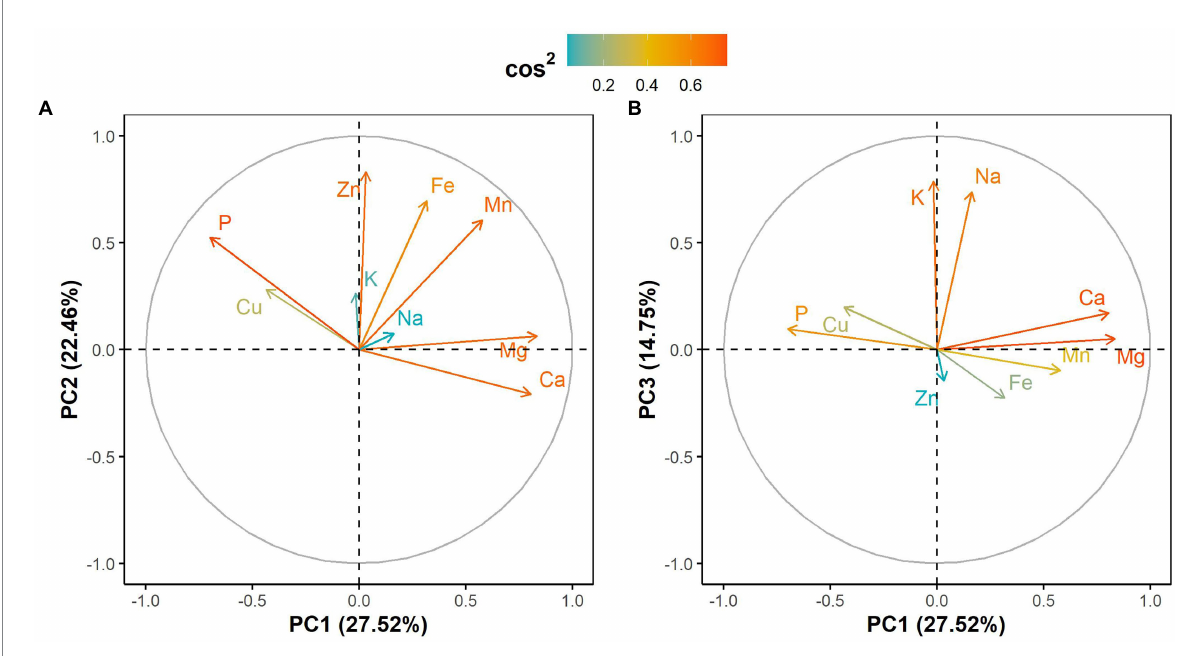
FIGURE 4 Correlation circle showing leaf mineral elements projection on (A) the first two principal components and (B) the first and third principal components. Cos 2 refers to the quality of representation for variables on the principal component.